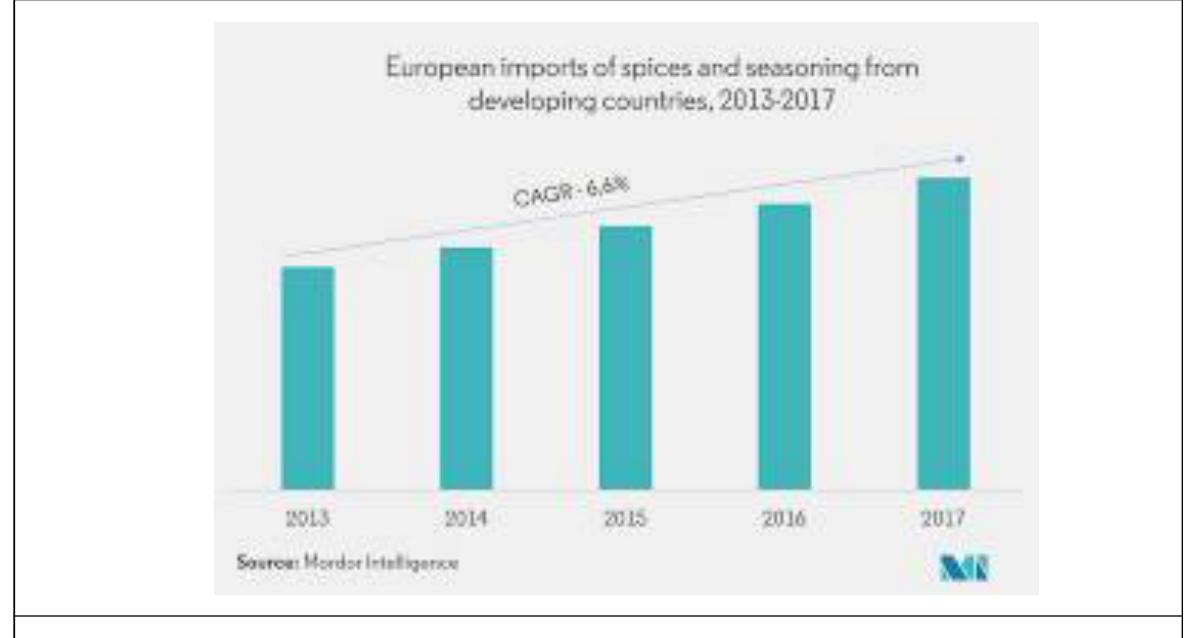
Figure 1: Imports of spices and seasonings from developing countries (2013-2017) Source: Mordor Intelligence; retrieved from www.nordorintelligence.com